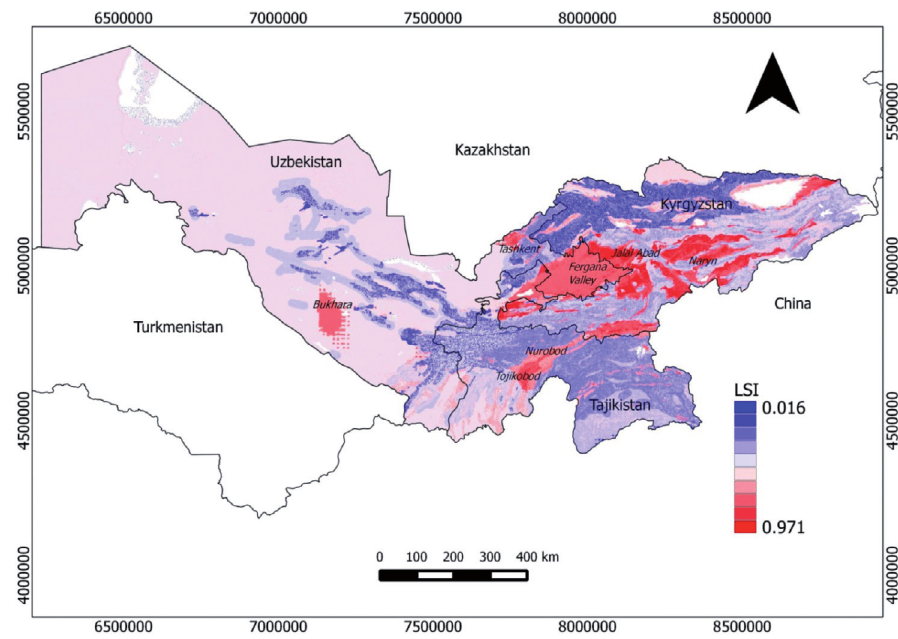
Figure 3. Landslide Susceptibility Index (LSI) map for Kyrgyzstan, Tajikistan and Uzbekistan calculated with respect to slope gradient, slope aspect, profile curvature, geology, distance from faults, and seismic intensity factors. Normalized susceptibility values are